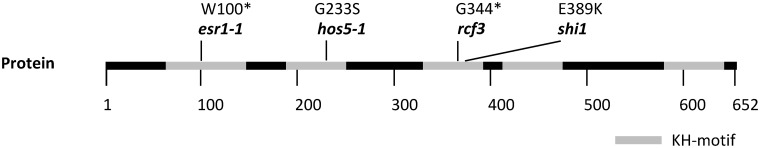
Location and effect of At5g53060/ESR1/RCF3/SHI1/HOS5 mutations.At5g53060 domain structure with the position and predicted nature of published mutations indicated relative to the first methionine.